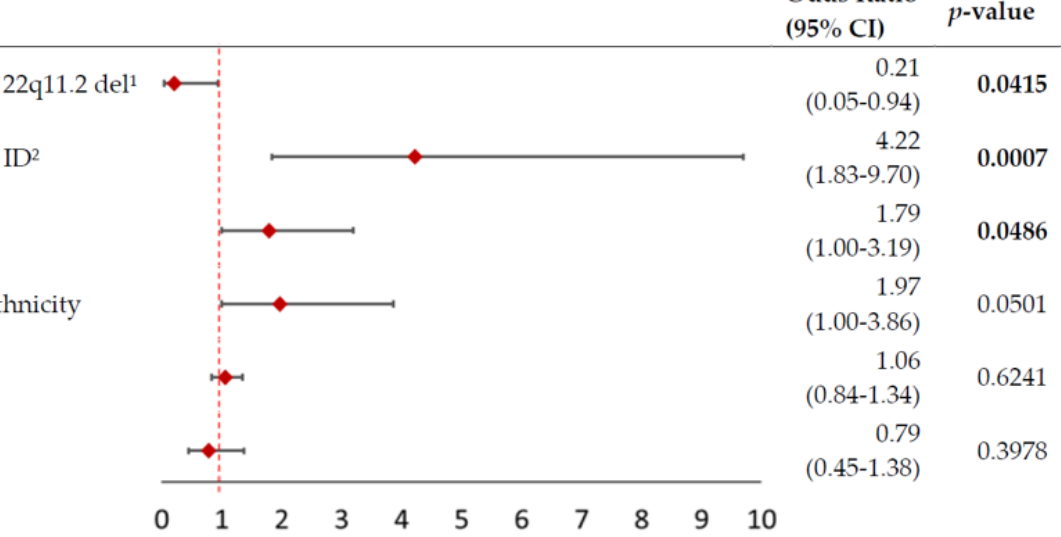
Figure 3. Forest plot of logistic regression model for short stature in 314 adults with 22q11.2DS. The figure shows odds ratios (OR, red diamonds) and 95% confidence intervals (CI, horizontal lines) for six possible predictors of short stature in 314 adults with a 22q11.2 microdeletion and known deletion extent. The overall logistic regression model was significant (likelihood ratio χ 2 = 24.5, df = 6, p = 0.0004). Significant values are shown in bold font. 1 Nested proximal 22q11.2 deletions (A ‐ B or A ‐ C; see Methods). 2 ID = intellectual disability (see Methods). 3 CHD = congenital heart disease (see Methods).